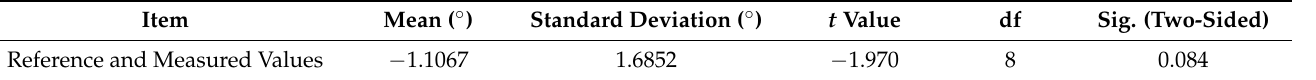
Table 4. t -test between reference and measured values of the angle of the wings angle of H. cunea samples.